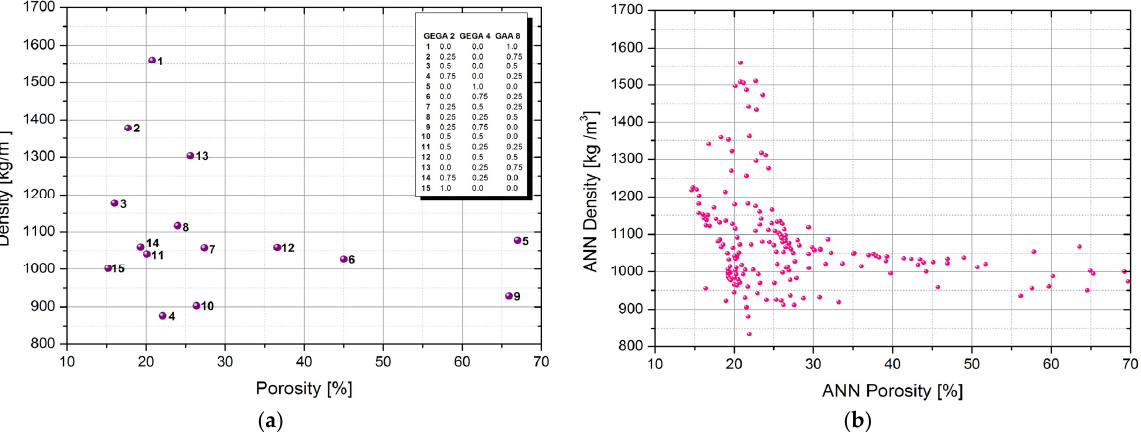
Figure 5. Graphical presentation of the relationship between density and porosity of the LWC based on: ( a ) the laboratory test results, ( b ) the ANN prediction.